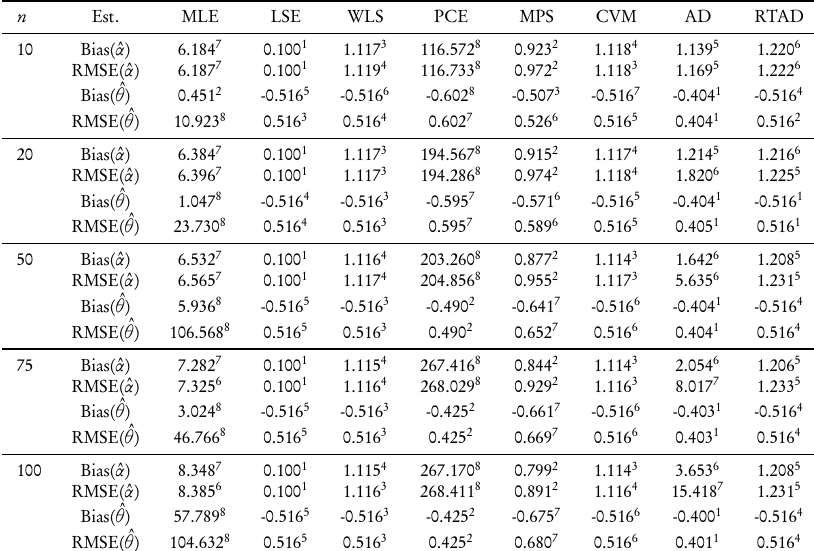
Simulation results for α = 5 , θ = 0.7 and λ = 1